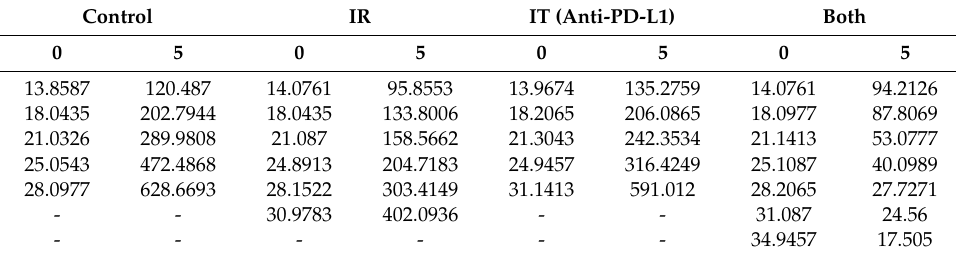
Table 1. Experimental data. Here, the control means without any therapy. IR therapy occurs on day 14 with 12 Gy, and IT therapy begins on day 14 and continues every three days for a total of four doses with 200 µ g. Both indicate a combination therapy of IR and IT and each column represents time and tumor size,